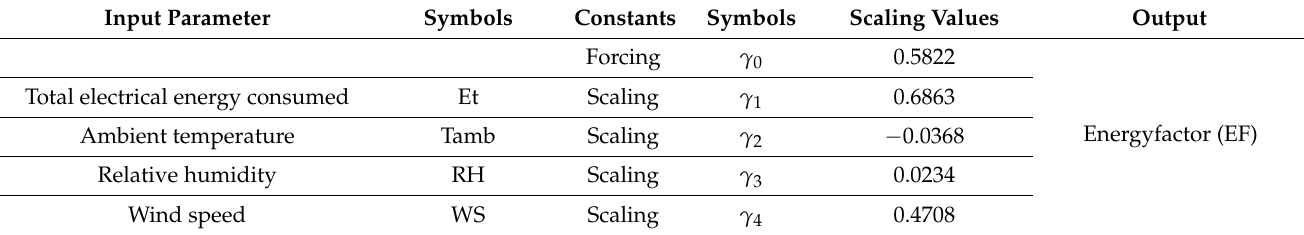
Table 6. Forcing and scaling values for the developed multiple linear regression model.